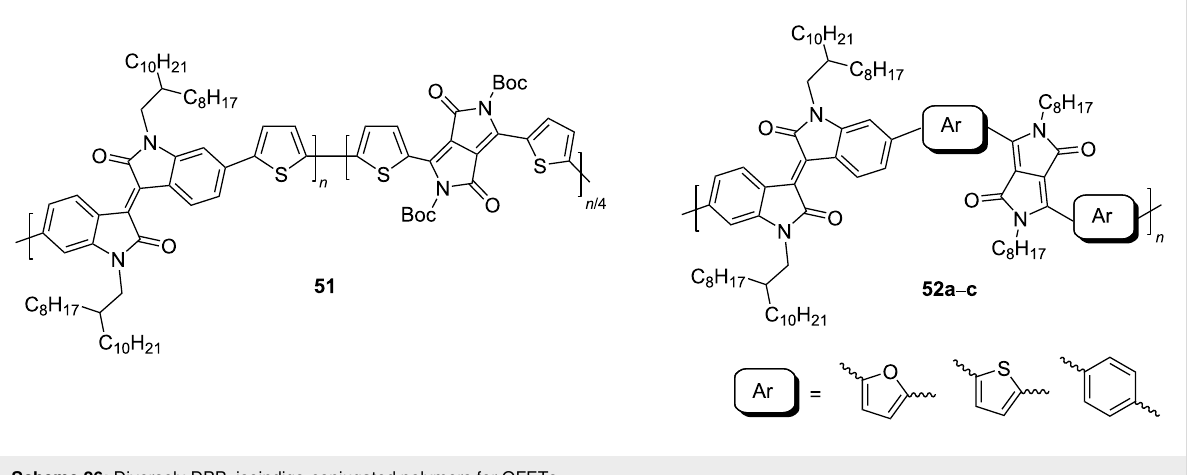
Scheme 26: Diversely DPP–isoindigo-conjugated polymers for OFETs.